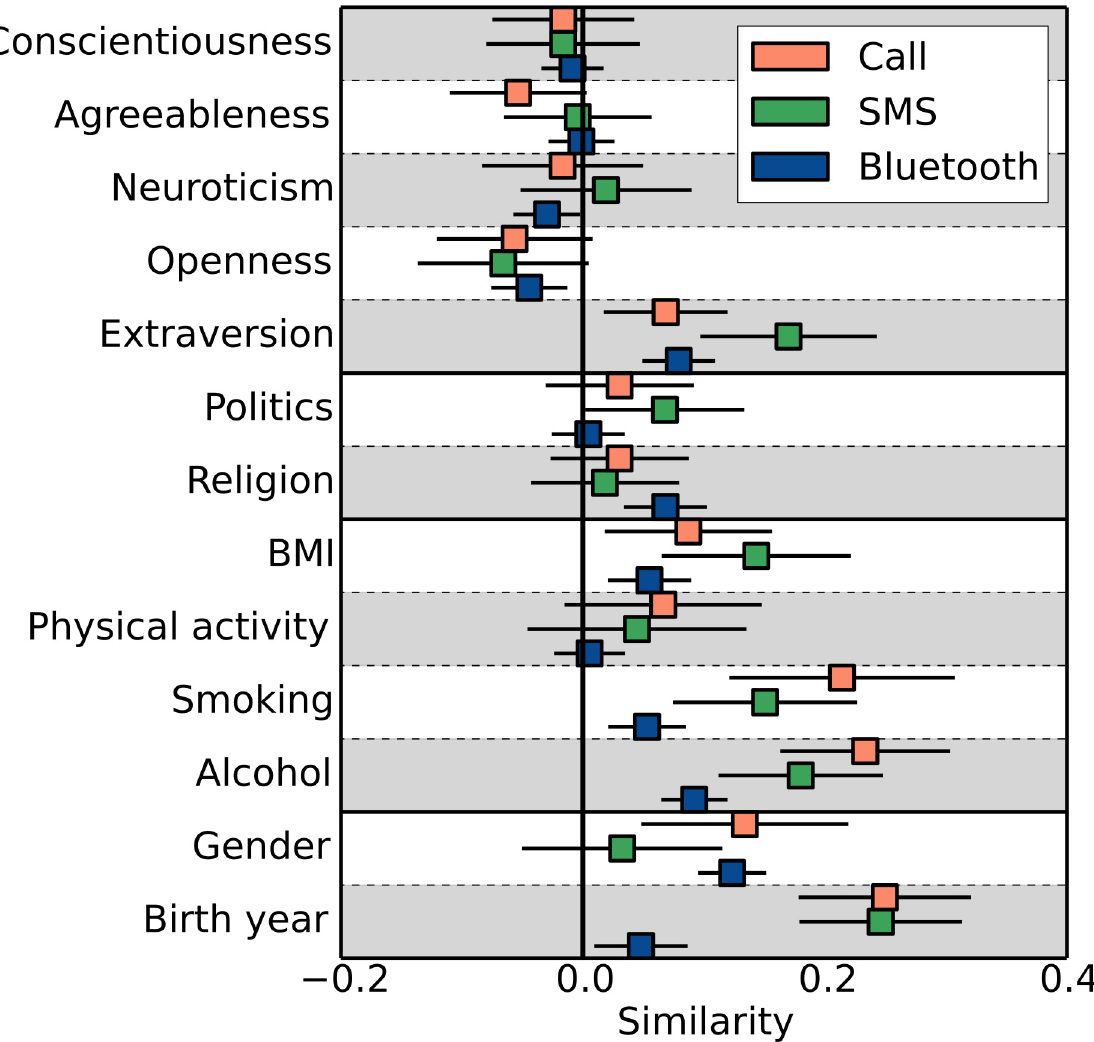
Fig 2. Similarity of connected individuals in the network. The bars show the intraclass correlation coefficient for the different variables and for the networks formed from call activity, SMS activity and proximity data. The lines have a range of one standard deviation. We find no similarity with regard to the personality traits conscientiousness, agreeableness and neuroticism but we find a weak similarity with regard to extraversion and dissimilarity with respect to openness. In general a stronger similarity is found for socio-demographic, behavior- and attitudes-related